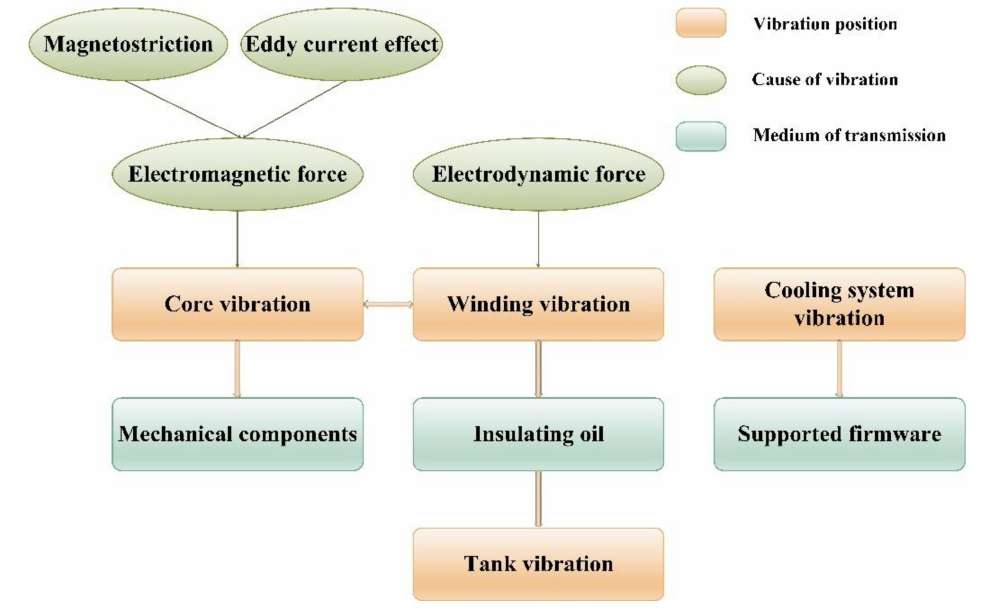
Figure 1. The vibration transmission path of converter